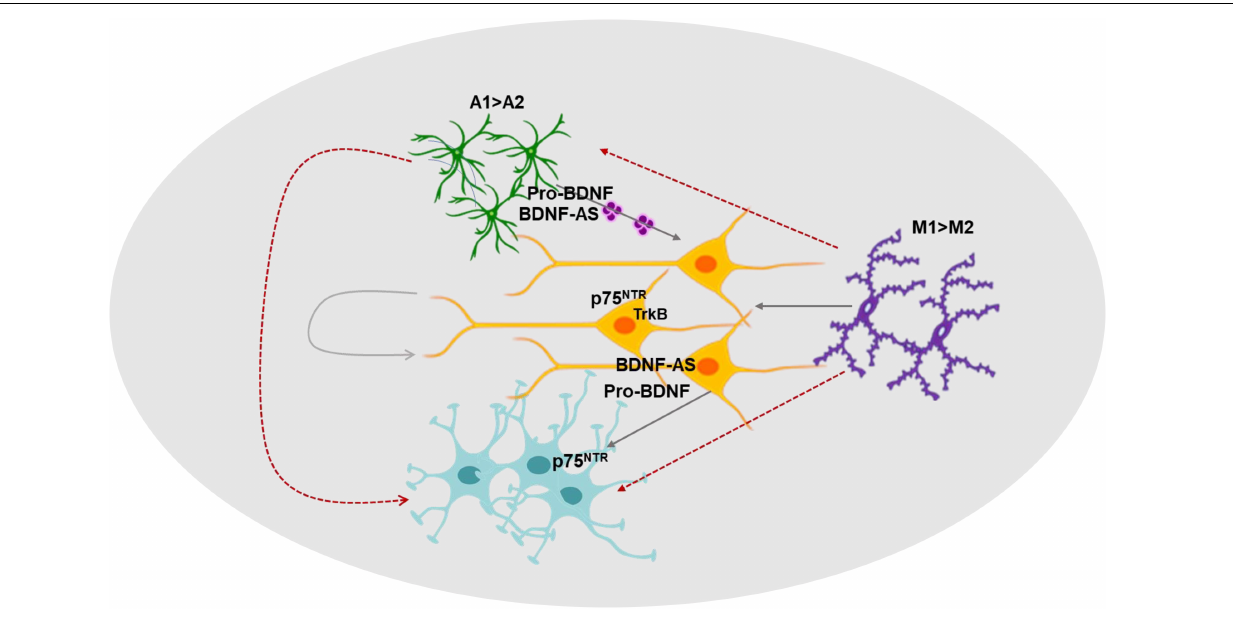
FIGURE 7 | A diagram summarizing the roles of neuron-glia interactions, the BDNF pathway and extracellular vesicles in ketamine’s effects. The effects of ketamine on various components of the BDNF pathway, the interactions of neuron and glial cells and the role of EVs as mediators of these interactions are depicted in this